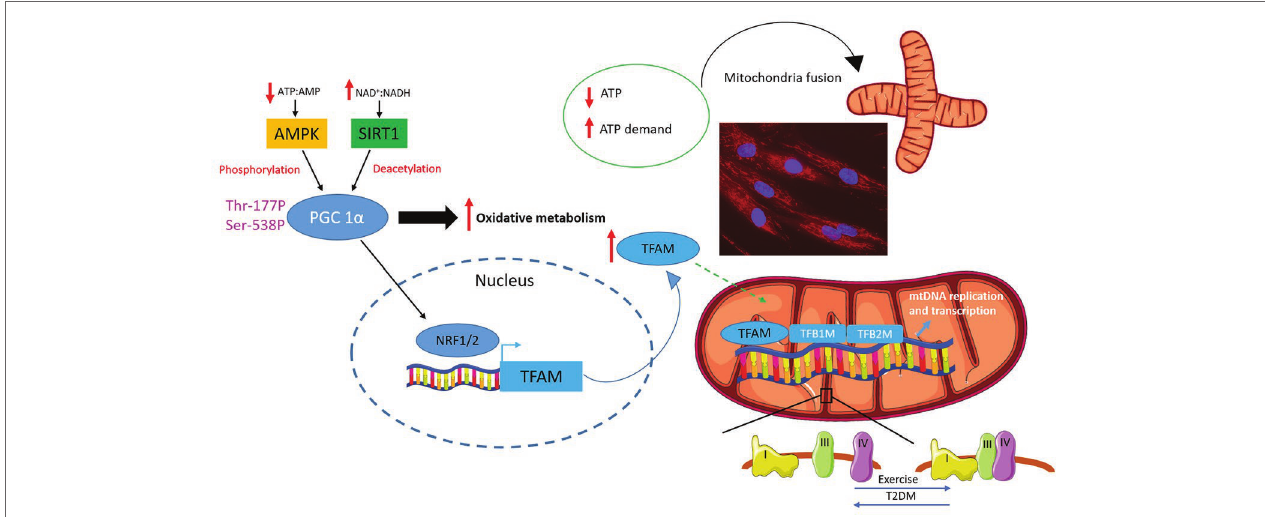
FIGURE 3 | Regulation of mitochondrial biogenesis, fusion and supercomplex formation. An increase in energy demand/decrease energy availability marked by a decrease in ATP:AMP and an increase in NAD+:NADH ratios is sensed by 5 ′ adenosine monophosphate-activated protein kinase (AMPK) and sirtuin-1 (SIRT1), respectively. These energy gauges activate the master regulator of mitochondrial oxidative metabolism and biogenesis: peroxisome proliferator-activated receptor γ co-activator 1 α (PGC 1 α ). PGC 1 α activates the nuclear respiratory factors 1 and 2 (NRF-1 and NRF-2), which in turn promotes the transcription of mitochondrial transcription factor A (TFAM). TFAM directly interacts with mitochondrial DNA (mtDNA) and, in concert with mitochondrial transcription specificity factors TFB1M and TFB2M, regulates mtDNA replication and transcription. Mitochondrial function is also modulated by shifts in mitochondria dynamics with a drop in ATP levels or an increase in ATP demand triggering mitochondria fusion also depicted in the fluorescent microscopy picture of myotube mitochondria stained with Mitotracker red (Thermo Fisher Scientific) (cells were purchased from Cook Myosite, USA). Finally, mitochondrial complexes can assemble into multimeric super assembled structures termed supercomplexes. The most abundant mitochondrial supercomplex is made up of complex I, III and IV also termed respirasome. Exercise has been shown to promote supercomplex formation, which, instead, was reported to be decreased in individuals affected by type 2 diabetes